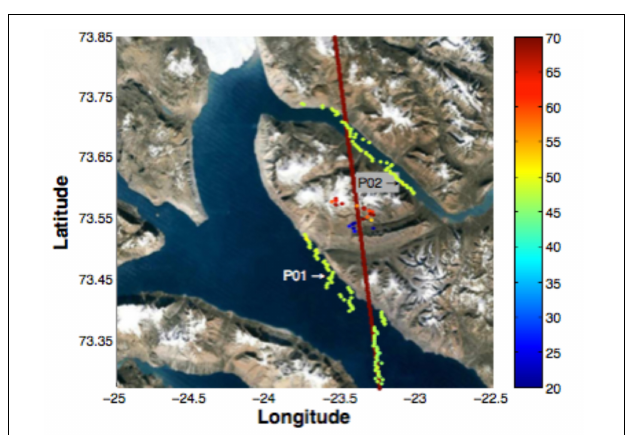
FIGURE 8 | Ascending track crossing the Fjords of Eastern Greenland. Dark red track correspond to the satellite nadir. Scattered points are relocated positions after the ONR corrections are applied. Two points are marked by P01 and P02 in the figure. The elevations are referenced to WGS84 ellipsoid. Unit: meters (adapted from Abulaitijiang et al., 2015).